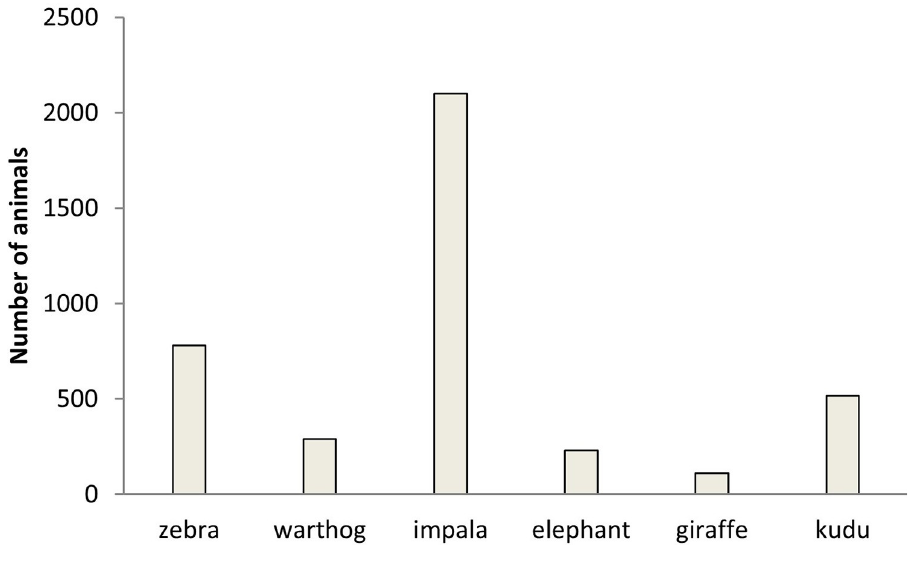
Fig 6. Number of wildlife at Debshan ranch in 2017.